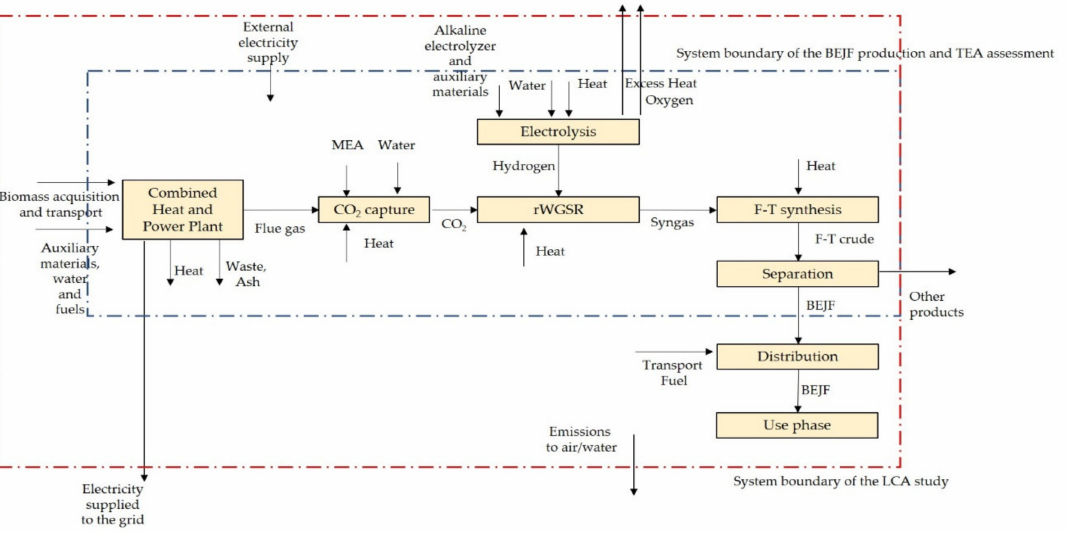
Figure 1. Illustration of the system boundaries applied to this work. The blue dotted line presents the system boundary and unit processes considered for the techno-economic assessment. The red dotted line presents the system boundary of the environmental assessment. Arrows represent the flows of materials, resources, and energy to and within the system and also the flows of energy and emissions from the studied system to the technical and natural